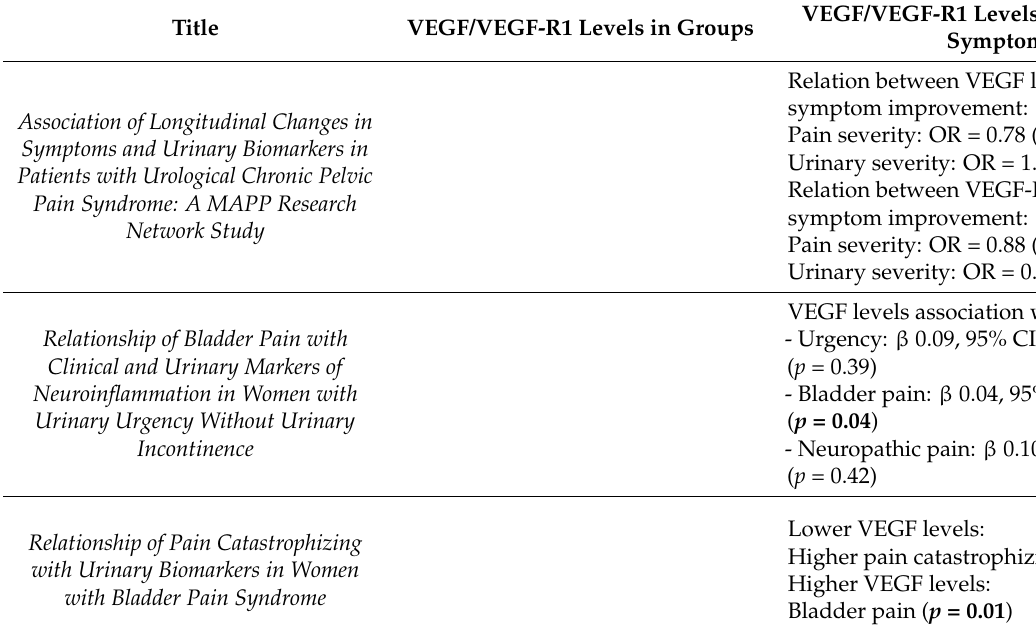
VEGF/VEGF-R1 Levels in